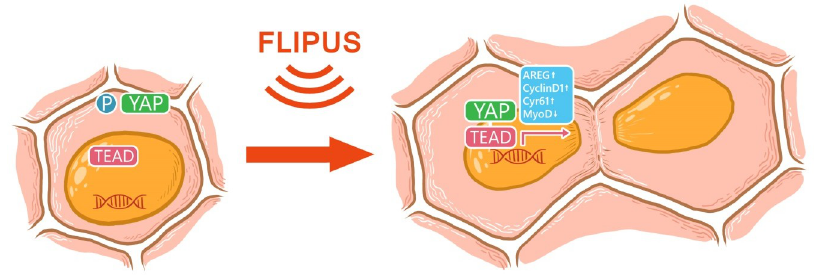
Fig 6. Hypothesized mechanotransduction mechanism regulating the pro-proliferative response of C2C12 cells to FLIPUS. FLIPUS treatment leads to dephosphorylation and nuclear translocation of YAP, resulting in the increased transcription of pro-proliferative